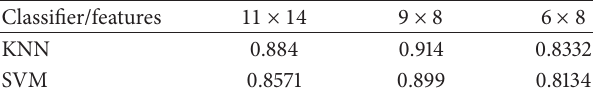
Table 1: Face recognition accuracy rate on DB